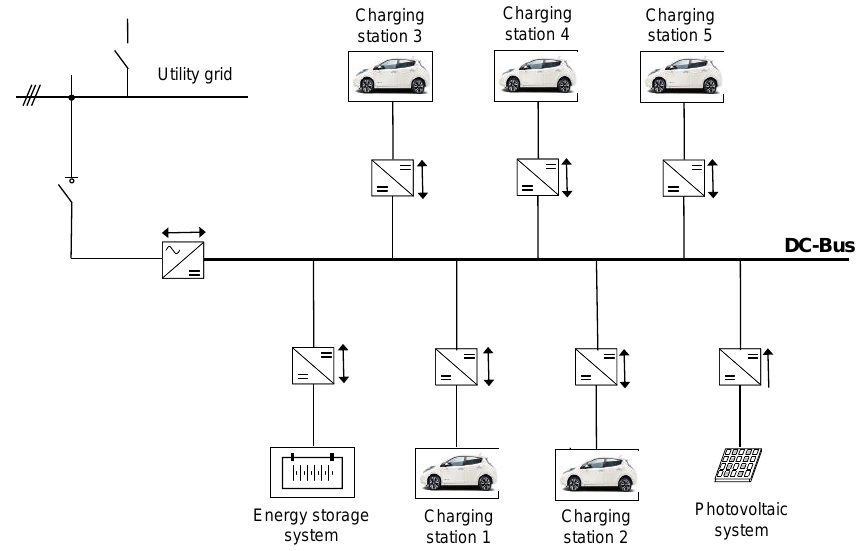
Figure 2. Grid scheme of the test direct-current (DC) microgrid.